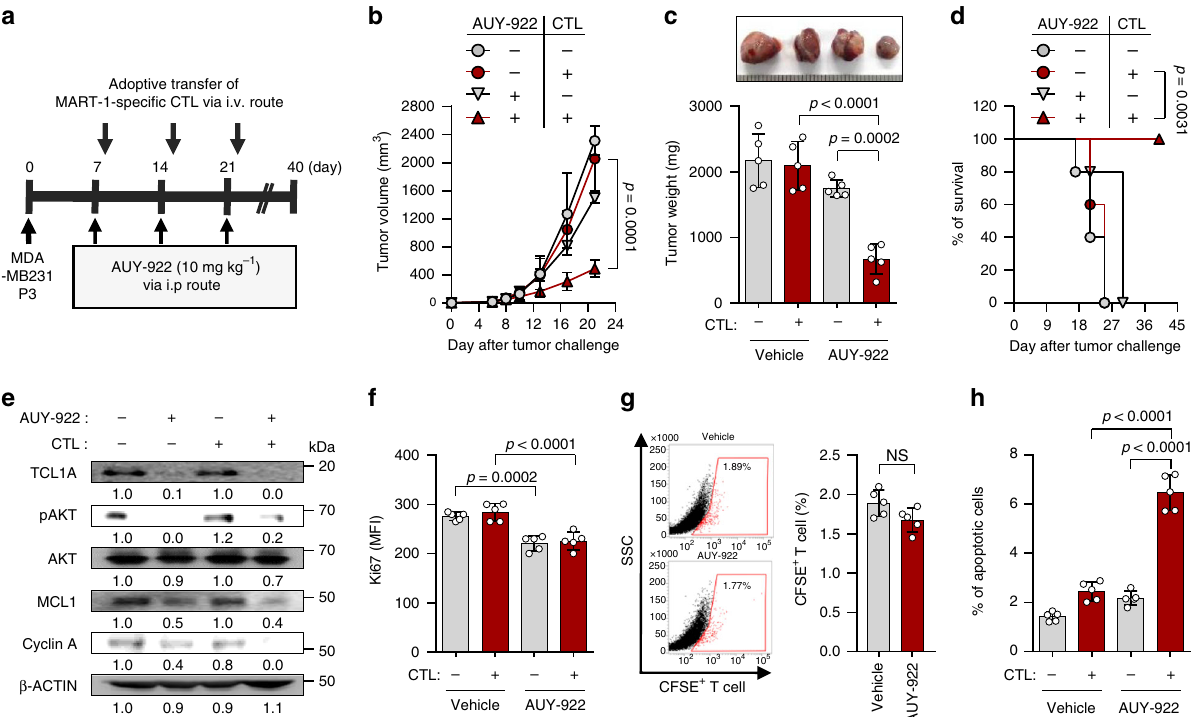
Fig. 6 HSP90A inhibition reverses the resistant phenotype to adoptive T cell therapy. a Schematic of the therapy regimen in NOD-SCID mice implanted with MDA-MB231 P3 cells. b Tumor growth, c mass (at 21 days after challenge), and d survival of mice inoculated with MDA-MB231 P3 treated with the indicated reagents. e Western blot analysis of TCL1A, pAKT, AKT, MCL1, Cyclin A protein in mice administered with PBS or AUY-922, with or without adoptive transfer of MART-1-speci fi c CTLs. β -ACTIN was included as an internal loading control. Numbers below blot images indicate the expression as measured by fold change. f The proliferation index of cells inside the tumor, as measured by the mean fl uorescence intensity of Ki67 staining. g Flow cytometric analysis of the frequency of CFSE-labeled MART-1-speci fi c CTL in the tumors of mice that received adoptive transfer. h The frequency